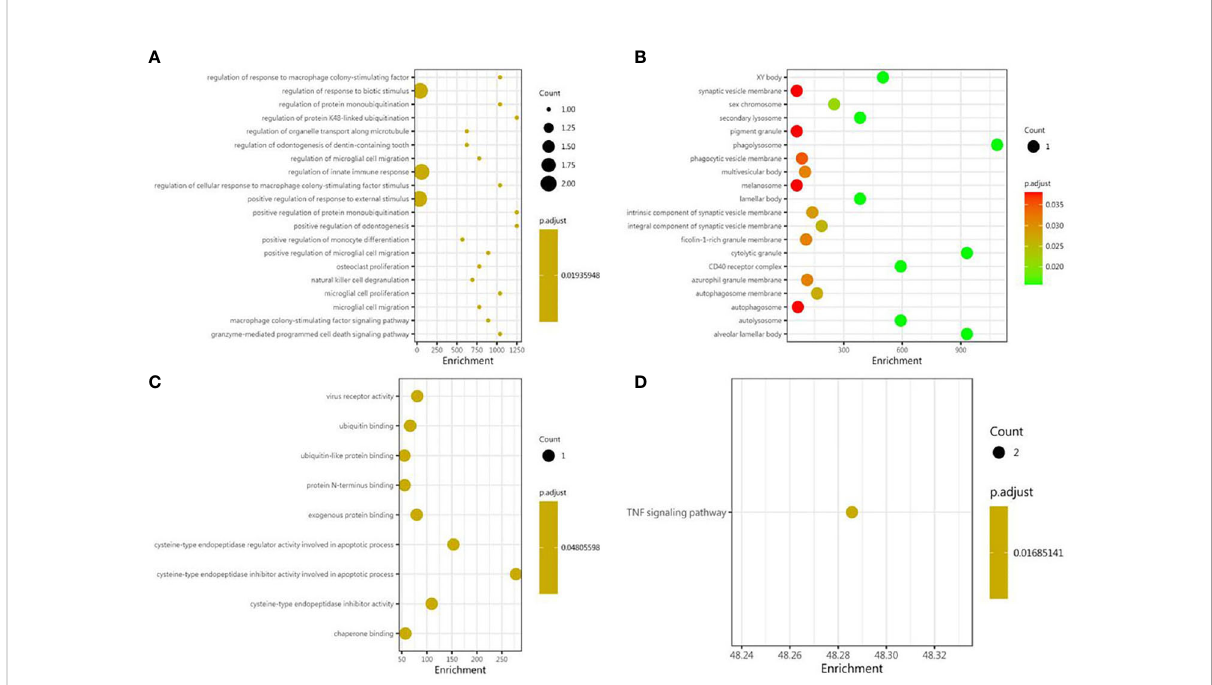
FIGURE 3 Bioinformatic analysis of differential proteins. Using Fisher ’ s accurate test, p < 0.05 was considered statistically signi fi cant. GO enrichment analysis included three subtypes: (A) cellular component; (B) molecular function; and (C) biological process. (D) The KEGG pathway